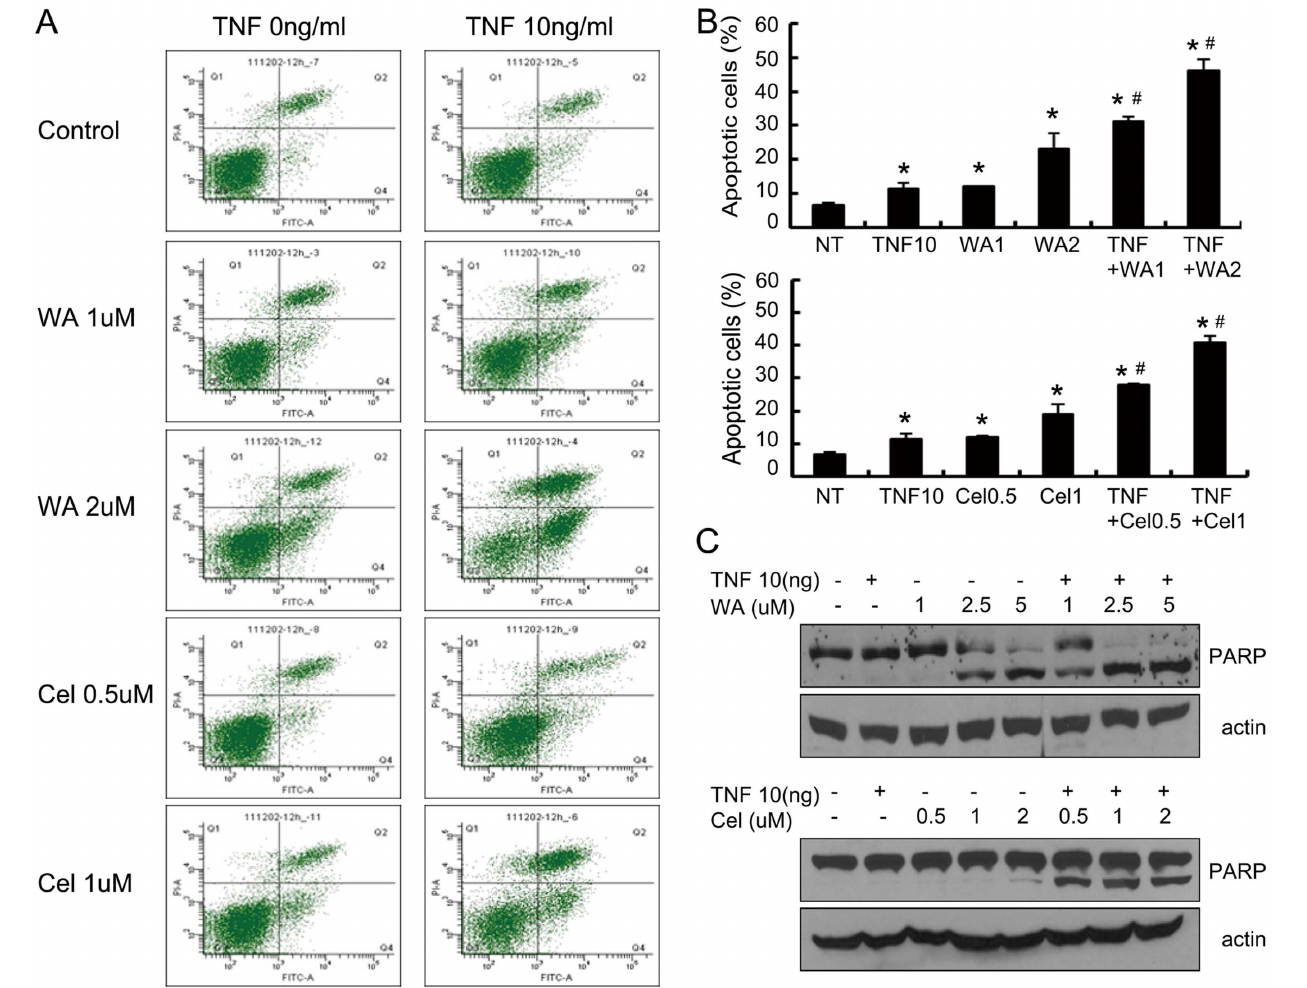
Figure 2. WA or Cel sensitize MDA-MB-231 cells to TNF- a -induced apoptosis. (A, B) Cells were treated with different concentrations of WA or Cel with (right) or without (left) TNF- a (10 ng/ml) for 48 hours, followed by measurement of cell viability by flow cytometry. (C) Cell death inducing abilities of WA and TNF- a or Cel and TNF- a combination in a dose responsive manner. Cells were treated with different concentrations of WA (upper) or Cel (lower) as shown with or without TNF- a (10 ng/ml) for 24 hours, followed by detection of PARP by Western blotting. Data are shown as mean ¡ SD of three experiments. (* P , 0.05, as compared with the untreated control. # P , 0.05, WA/Cel treated versus WA/Cel + TNF- a